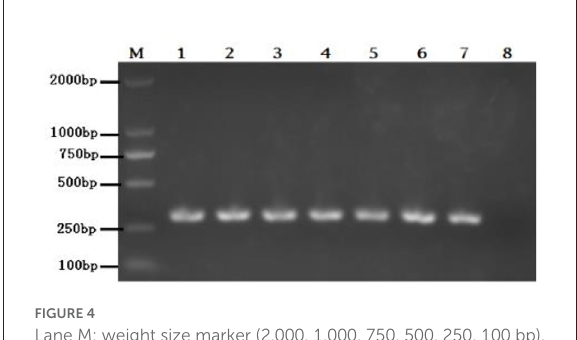
FIGURE4 Lane M: weight size marker (2,000, 1,000, 750, 500, 250, 100 bp), lanes 1–6: isolate GSLY, GSLZ, SXHY, XJFK, NXYC, and NXWZ, respectively, lane 7: positive control; lane 8: negative control.